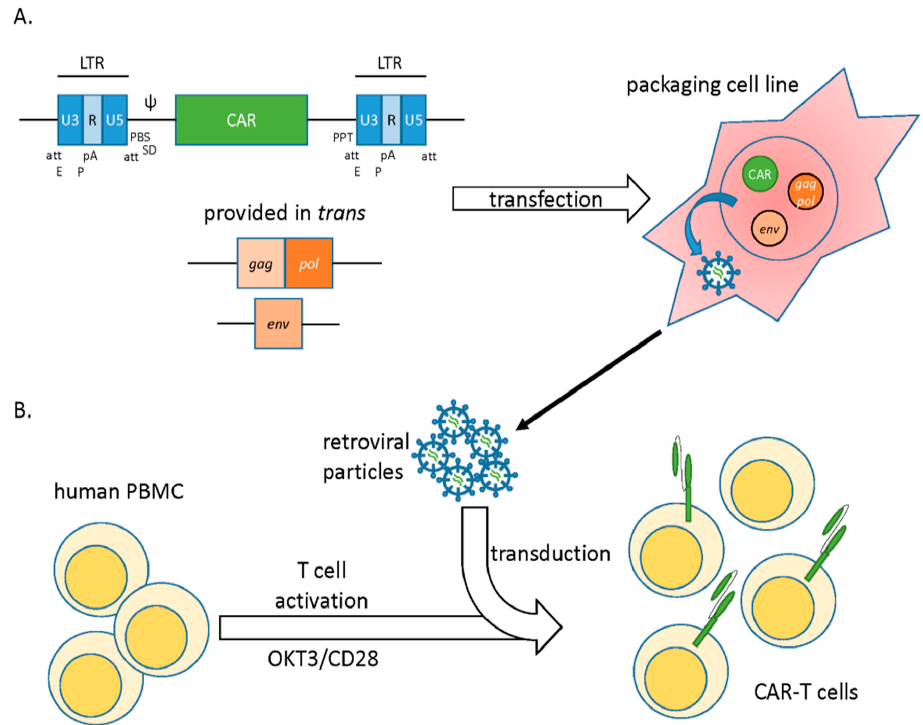
Figure 1. Gamma retroviral vectors. ( A ) Genomic structure of MLV-derived γ -retroviral vectors. Essential genes gag , pol , and env are removed from the viral backbone and provided in trans for viral production. Transgene encoding CAR is introduced in place of the viral genes . A packaging cell line is transfected with the vector carrying the CAR transgene, packaging and env helper plasmids. If desired, selective antibiotic pressure is utilized to select for plasmid integration and generate stable virus-producing lines for large-scale production. ( B ) Retroviral particles are collected from the cell culture supernatant and used to transduce stimulated T cells (OKT3/CD28 blasts). After genomic integration, the CAR is stably expressed on the surface of T cells. att, integration signal; E, enhancer; P, promoter; pA, polyadenylation signal; PBS, tRNA primer-binding site; SD, Splice donor; Ψ , encapsidation signal; PPT, polypurine tract.